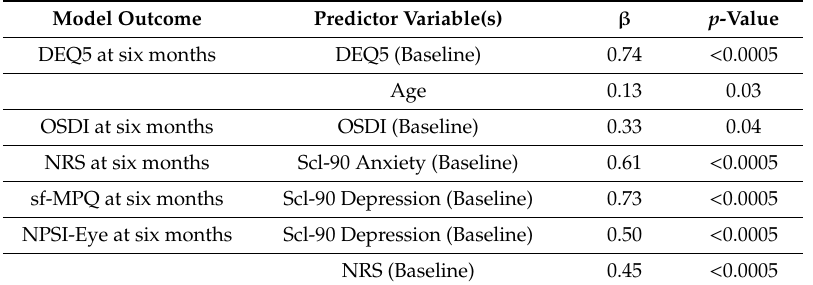
Table 5. Multivariable Analyses on Factors Predictive of DE Symptom Frequency and Severity.